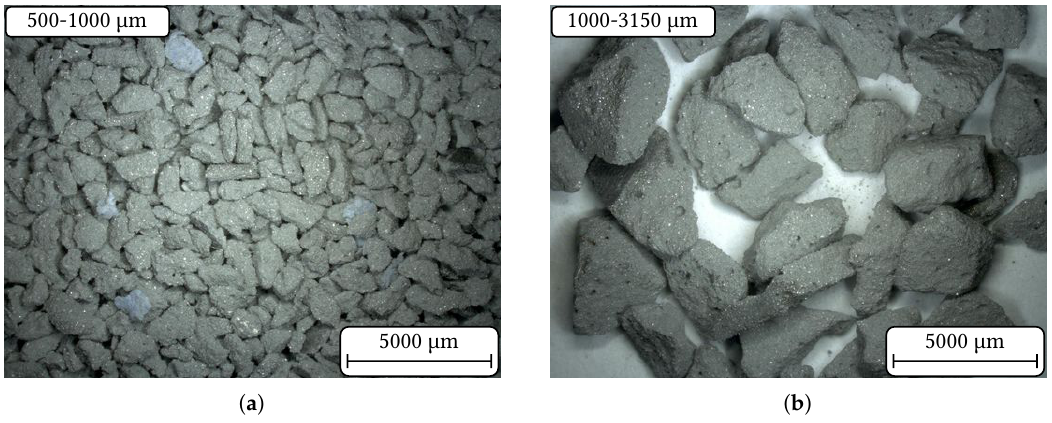
Figure 3. Photographs of the synthesised aggregate fractions ( a ) 500–1000µm and ( b ) 1000–3150µm.